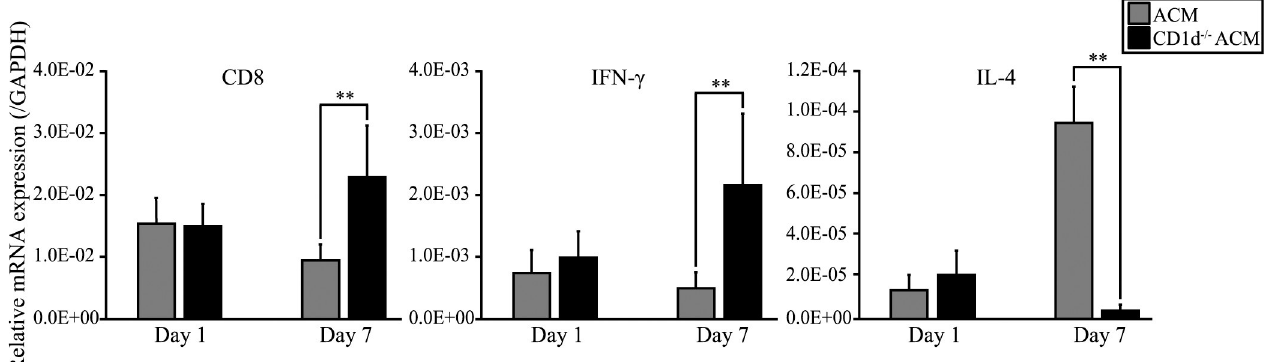
Fig 11. mRNA expressions of CD8, IFN- γ and IL-4 in CD1d -/- ACM mice. The mRNA expression levels of CD8, IFN- γ and IL-4 in the buccal mucosa were assessed at days 1 and 7 after challenge. GAPDH gene expression was used as an internal control. At day 7 after challenge, the buccal mucosa mRNA levels of CD8 and IFN- γ were significantly higher in CD1d -/- ACM mice compared with ACM mice. IL-4 was significantly higher in ACM mice compared with CD1d -/- ACM mice at day 7 after challenge. Bars and error bars indicate the mean plus standard deviation. Statistical significance was tested by the Mann–Whitney U- test ( �� p <